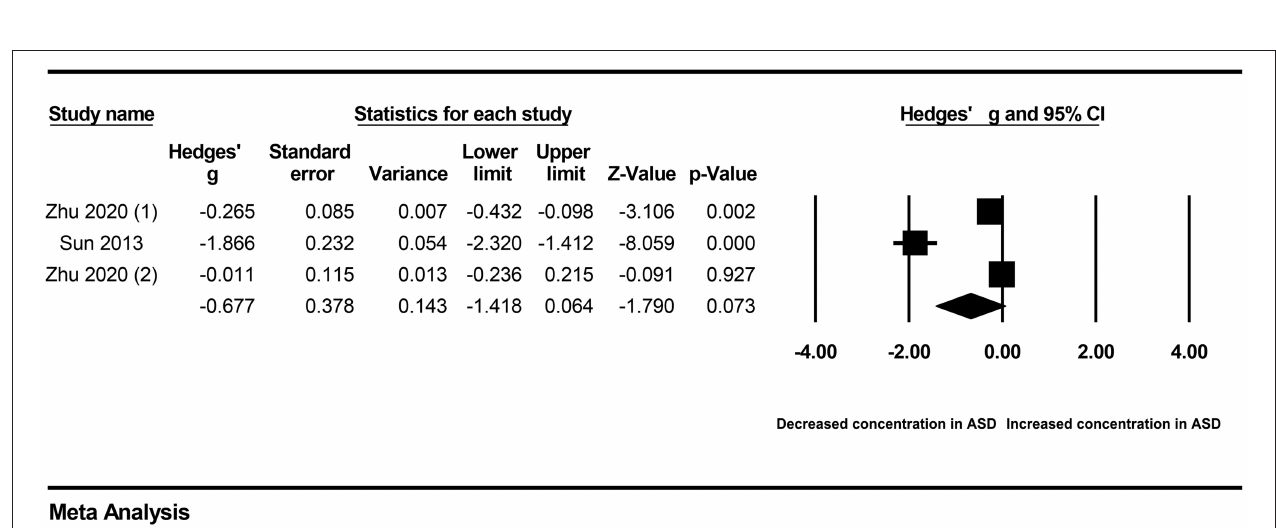
FIGURE 3 | Forest plot for the random-effects meta-analysis of the serum subgroup.